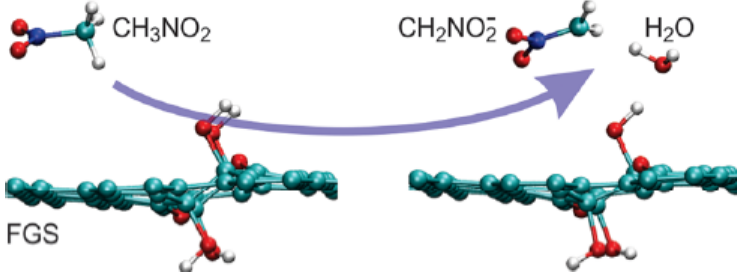
Figure 11. Initial decomposition of nitromethane on graphene sheets.